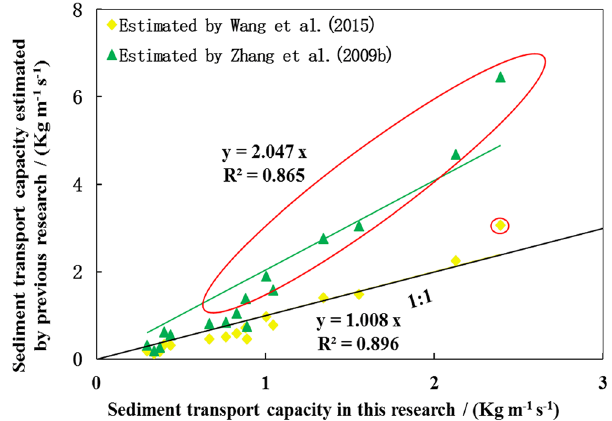
Figure 4. A comparison sediment transport capacity estimated by the equations in Zhang et al . 17 and Wang et al . 18 under non-erodible condition and that in our